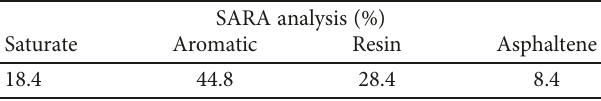
Table 1: Results of SARA analysis for the crude oil